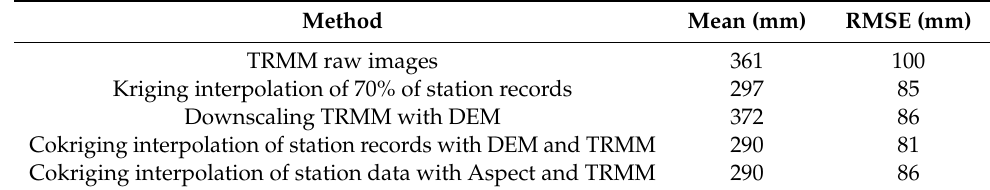
Table 4. Root Mean Square Error (RMSE) of di ff erent methods for precipitation estimation in Lake Urmia basin in 2007.